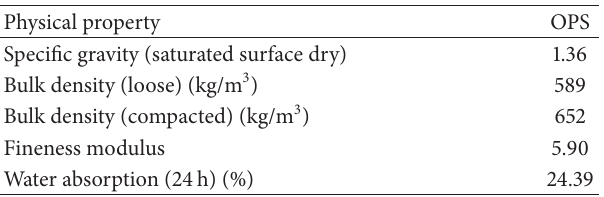
Table 2: Physical properties of OPS.